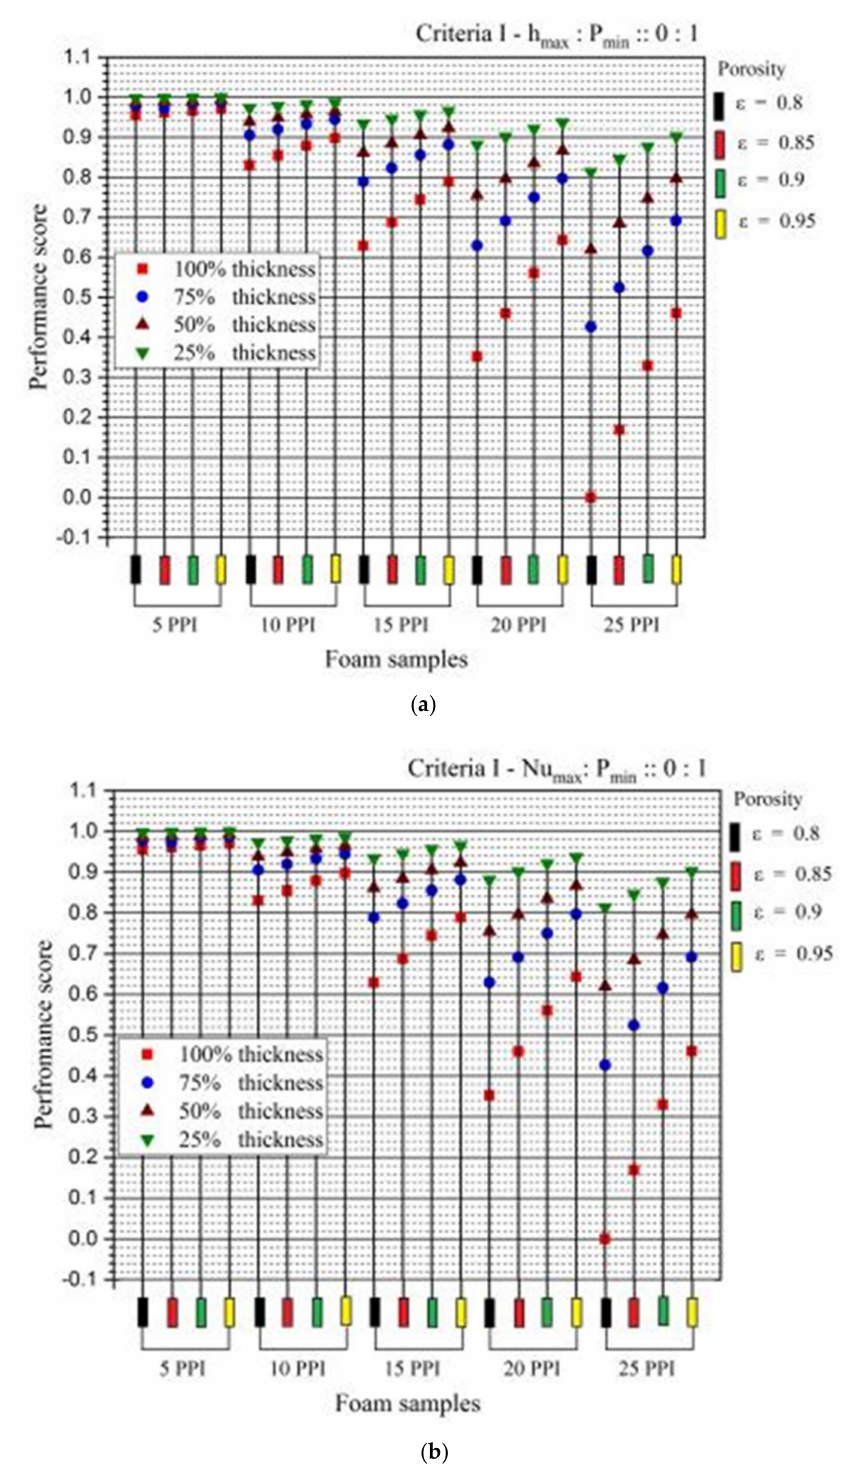
Figure 10. ( a ) Criteria I (h max :P min ). ( b ) Criteria I (Nu max :P min